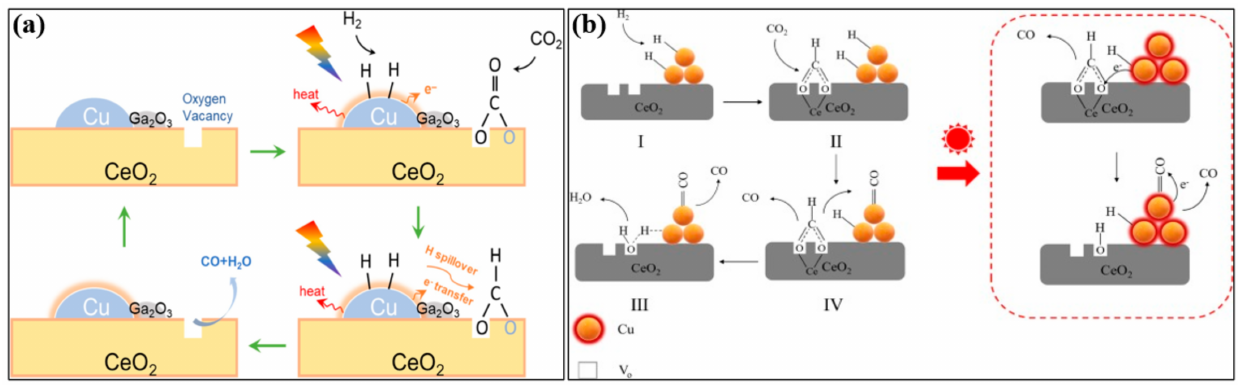
Figure 8. The associative mechanism of the RWGS reaction over ( a ) 10Ga5Cu − CeO 2 , reprinted with permission from [98]. Copyright Elsevier, 2021, ( b ) Cu − CeO 2 , reprinted with permission from [100]. Copyright Elsevier,